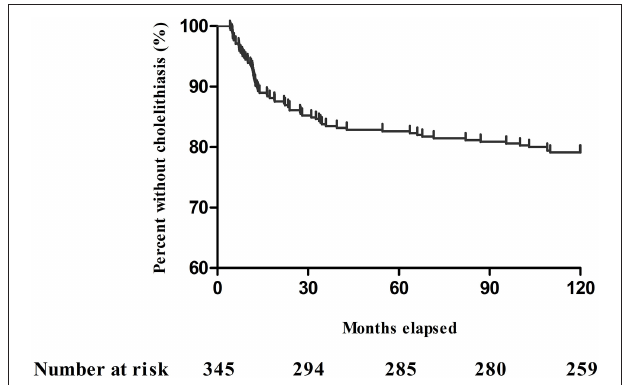
FIGURE 2 | Kaplan–Meier plot showing adult patients with short bowel syndrome without cholelithiasis during the 10-year period.